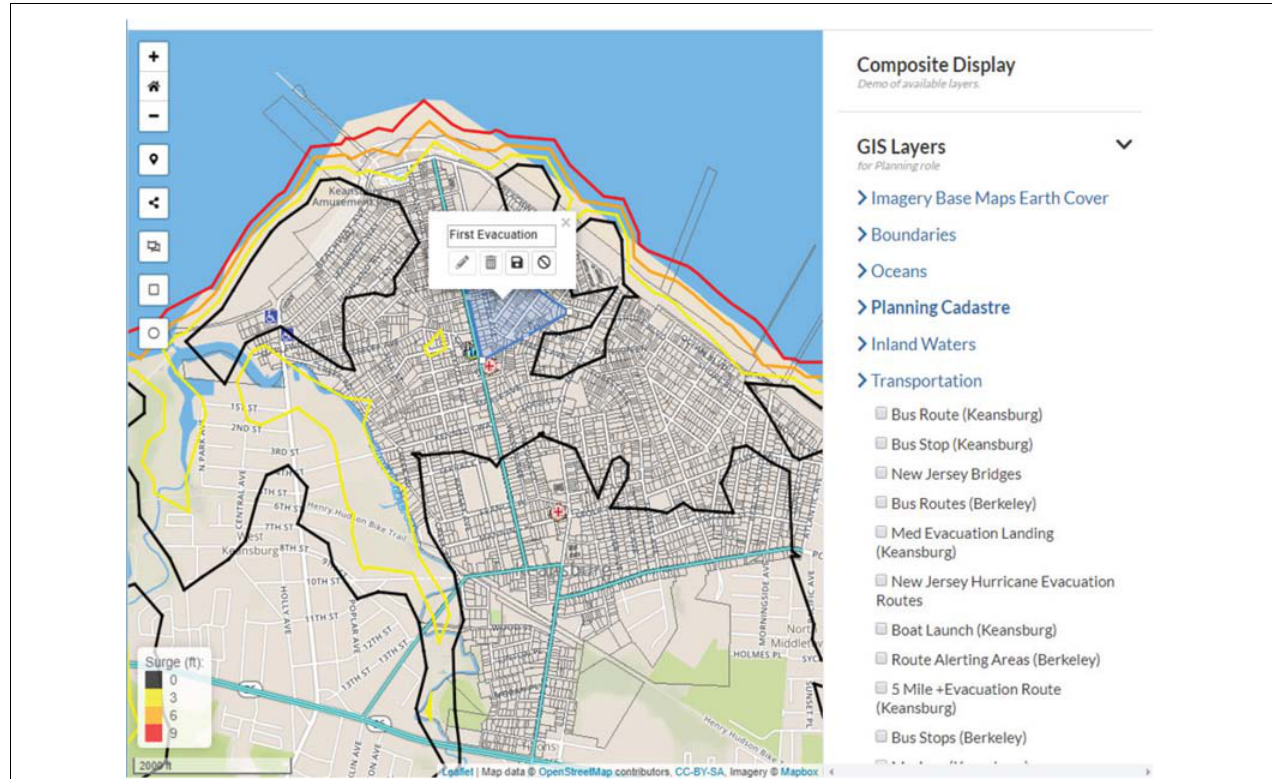
FIGURE 7 | Example of map displaying storm surge contours against parcel data and locations of critical facilities, engaging the annotation toolset to add labeled polygons to the map.